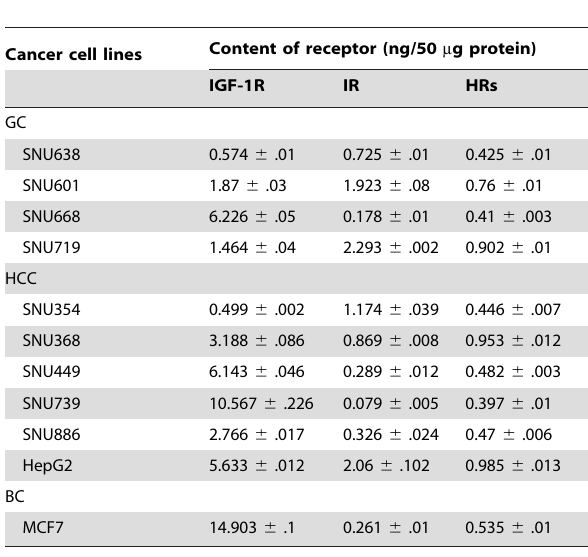
NOTE: Values are mean 6 SEM nanograms of receptor protein/50 m g total